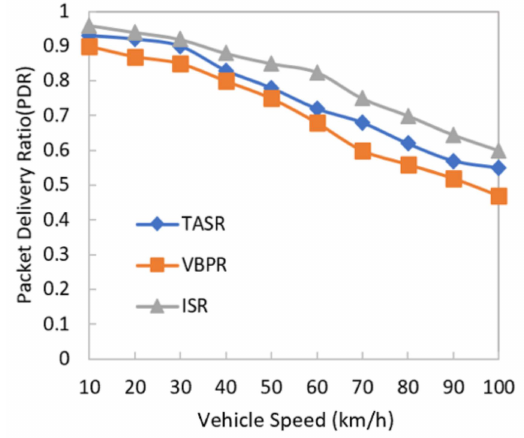
Figure 9. Comparison of packet delivery ratio with increasing vehicle speed.